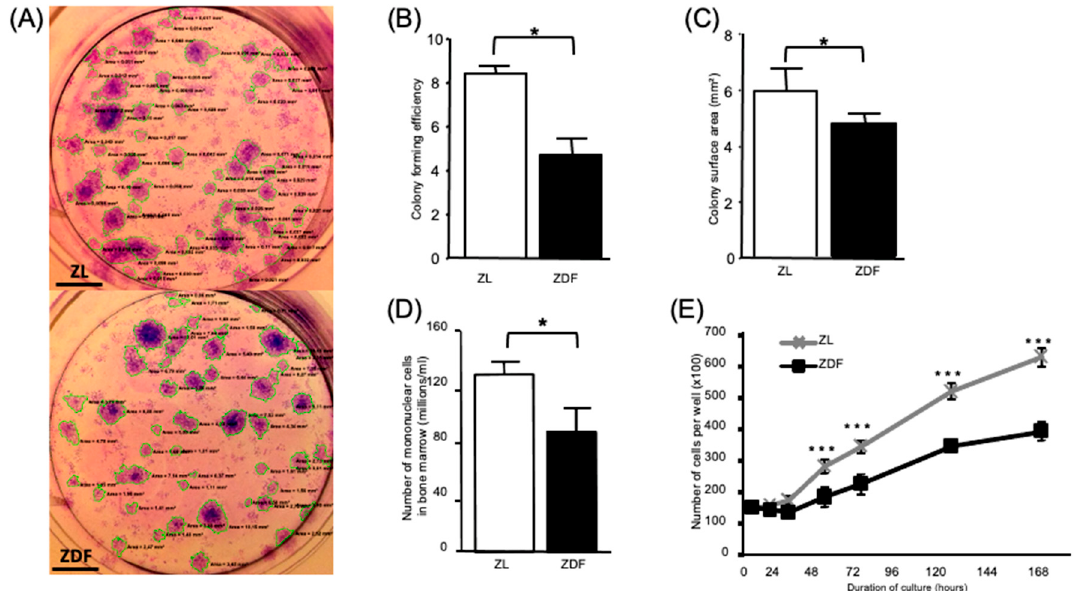
Figure 1. Type 2 diabetes mellitus (T2DM) affects the number, clonogenicity, and proliferation of cultured bone marrow- derived multipotent stromal cells (BMMSCs). Formation of fibroblastic colonies (CFU-Fs) in complete medium was assayed using bone marrow mononuclear cells from diabetic (ZDF) and non-diabetic (ZL) rats. ( A ) Representative images of CFU-F colonies, Scale bar = 0.5 cm ( B ) The colony forming efficiency (CFE), ( C ) The average area of each colony shown in Figure 1A, ( D ) The number of mononuclear cells present in the collected bone marrow, counted after isolation of the BMMSCs from two tibiae and two femurs per rat (n = 3), and ( E ) The number of ZDF-BMMSCs in alpha-Modified Eagle’s Medium ( α MEM) containing 10% Fetal bovine serum (FBS), exhibiting lower proliferation over a 7-day period of culture. Values are mean ± standard error of the mean (SEM). The data are from 3 independent wells per condition tested in 3 independent experiments (n = 9). * P < 0.05; *** P < 0.001.